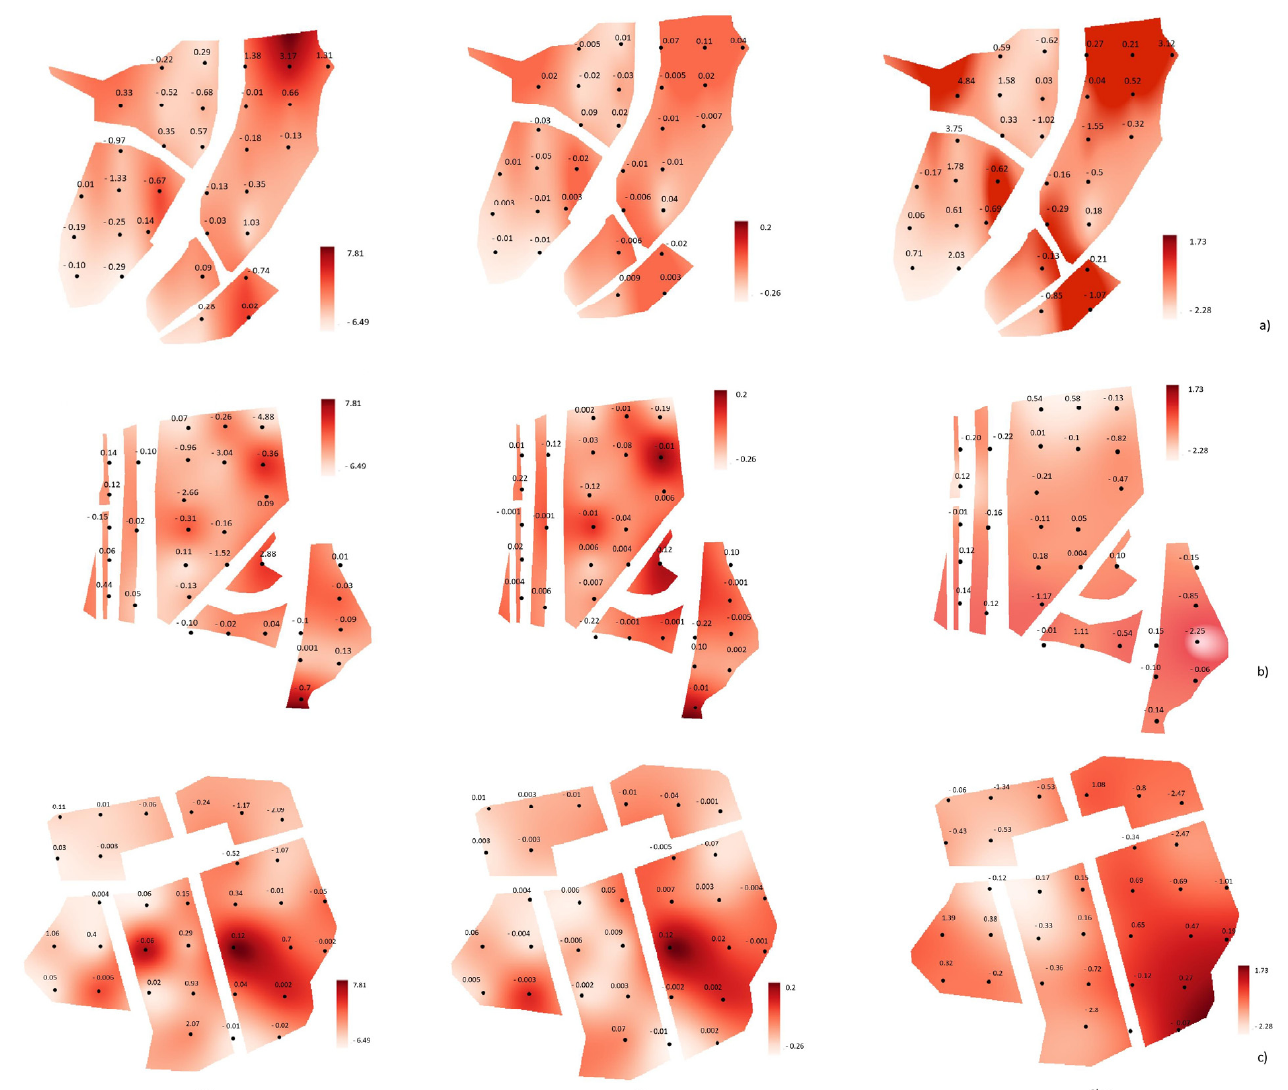
Figure 7. Difference (%) in OM, N and clay content, from the comparison of laboratory analysis and spectroscopy data; ( a ) Lobeira, ( b ) Monteveiga and ( c ) Ribadulla.